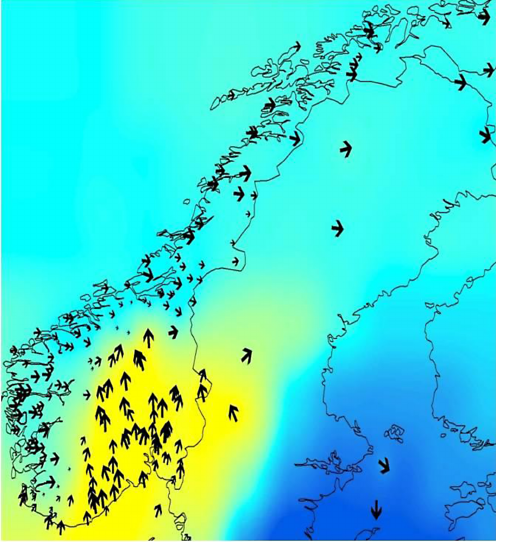
Figure 4. Dominant wind direction on the 30 days with the highest precipitation values at each station.